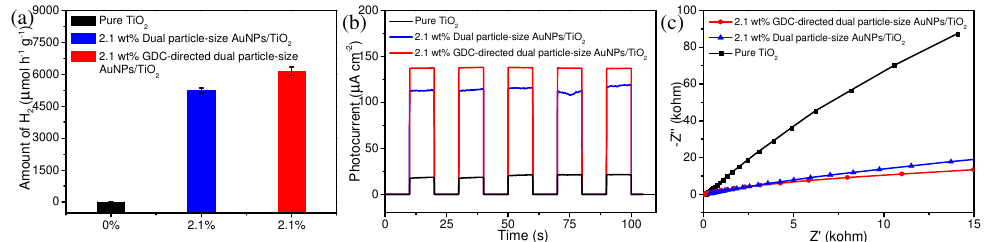
Figure 8. ( a ) Photocatalytic H 2 generation rates, ( b ) transient photocurrent responses, and ( c ) electrochemical impedance spectroscopy Nyquist plots of pure TiO 2 , 2.1 wt% dual particle-size AuNPs/TiO 2 , and 2.1 wt% GDC-directed dual particle-size AuNPs/TiO 2 photocatalysts under light irradiation (350–780 nm).